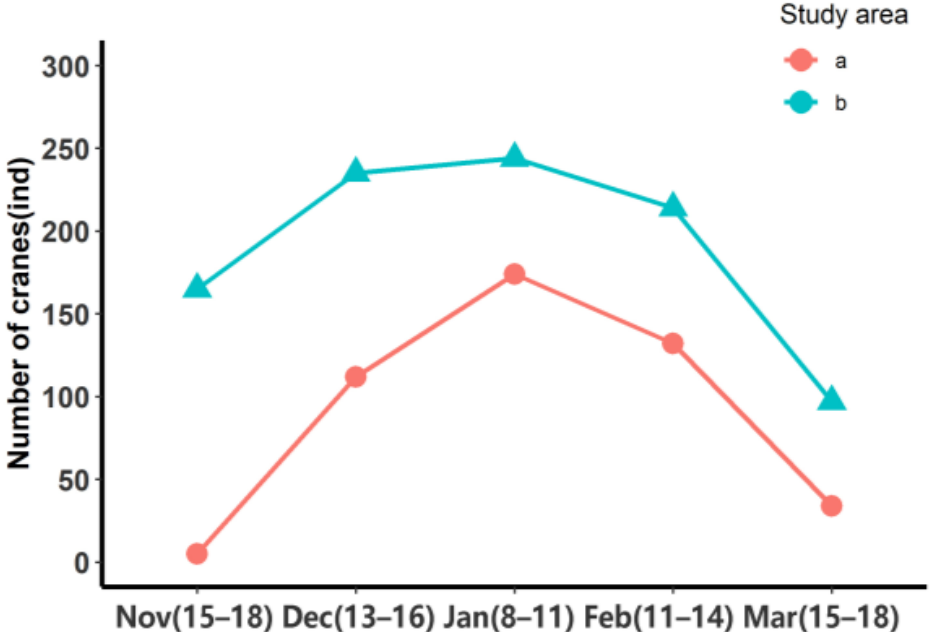
Figure 2. Population changes of Hooded Cranes in different months in the study area at (a) Caizi and (b) Shengjin Lakes.